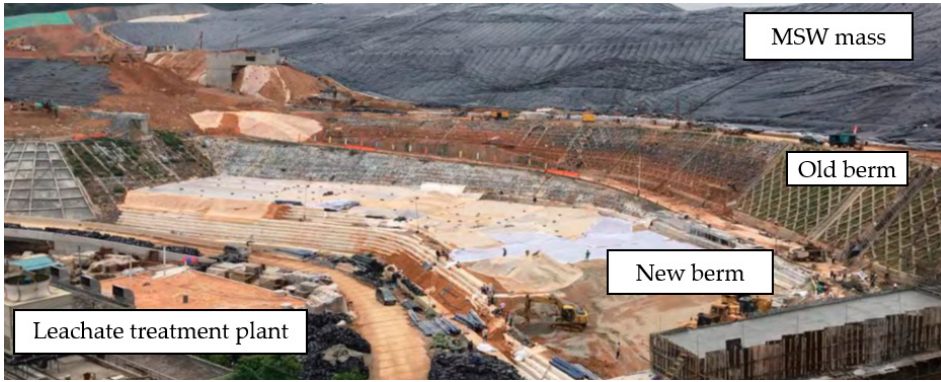
Figure 1. Photo of a new geosynthetic-reinforced soil (GRS) berm being raised and expanded.